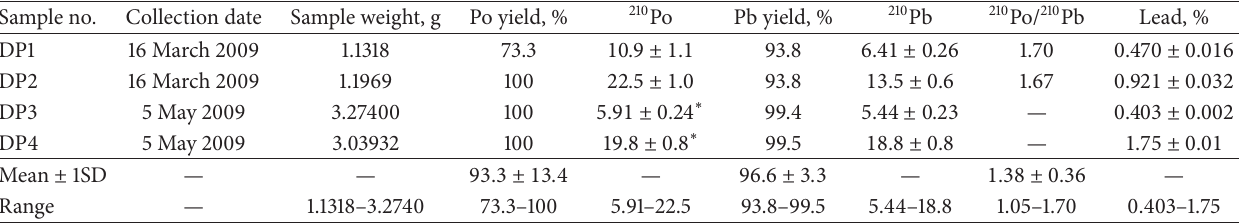
Table 7: The 210 Po and 210 Pb concentrations in kBq kg − 1 and lead contents in the dust particle samples collected from the first (DP1 and DP3) and second (DP2 and DP4) filtration systems of the ILVA Taranto on 16 March–5 May 2009. Sample no.